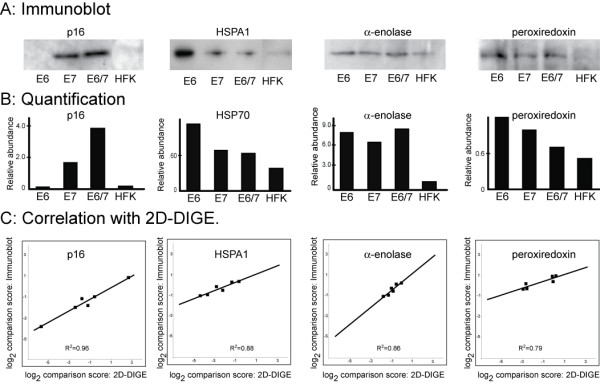
Correlation of immunoblot analysis and 2D-DIGE. A. Immunoblotting was performed as described in the Methods section using lysates from the same cells as for 2D-DIGE. For HSPA1, 5 μg of protein extract was analyzed by 8% SDS-PAGE. For all others, 30 μg extract was analyzed by 14% SDS-PAGE. Immunoblots were developed using a fluorogenic dye (ECF, GE Healthcare). B. Quantification of the immunoblots in Panel A by Kodak 1D 3.5 imaging software. C. Correlation between 2D-DIGE and immunoblot results. Six intergroup comparisons were made. Three were individual comparisons: E6 v. HFK, E7 v. HFK, and E6/7 v. HFK. Three were grouped comparisons: sum of HFK and E6 v. sum of E7 and E6/7, sum of HFK and sum of E7 v. E6 and E6/7, and sum of HFK and E6/7 v. sum of E6 and E7.